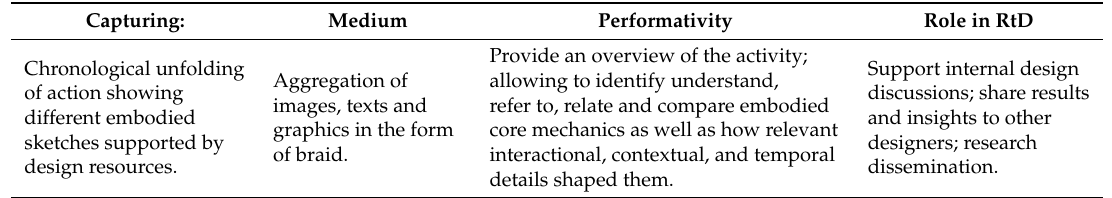
Table 1. Overview of the Bodystorming Braid’s core qualities and what it